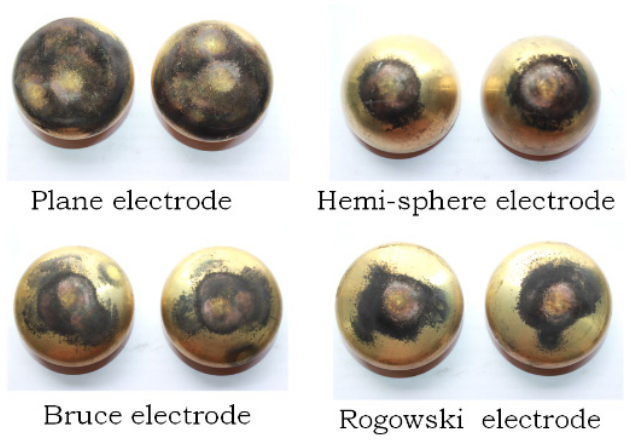
Figure 15. Discharge signatures on various electrode profiles.